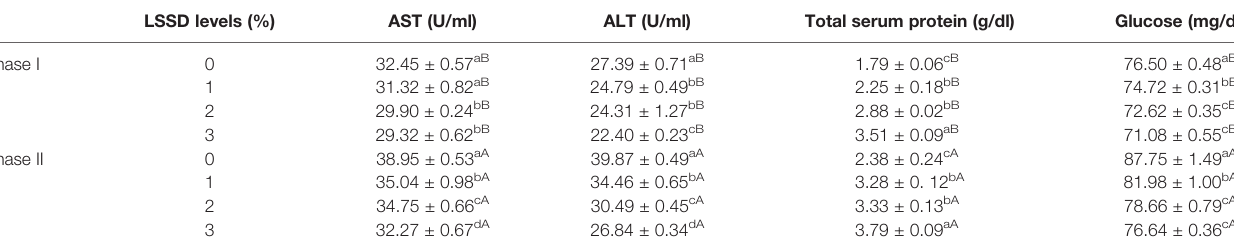
TABLE 6 | Biochemical indices of O. niloticus fed 0, 1, 2, and 3% diet of L. siceraria seeds supplemented diets (LSSD) for 60 days (Phase I) and after exposure to A. hydrophila (Phase II). LSSD levels